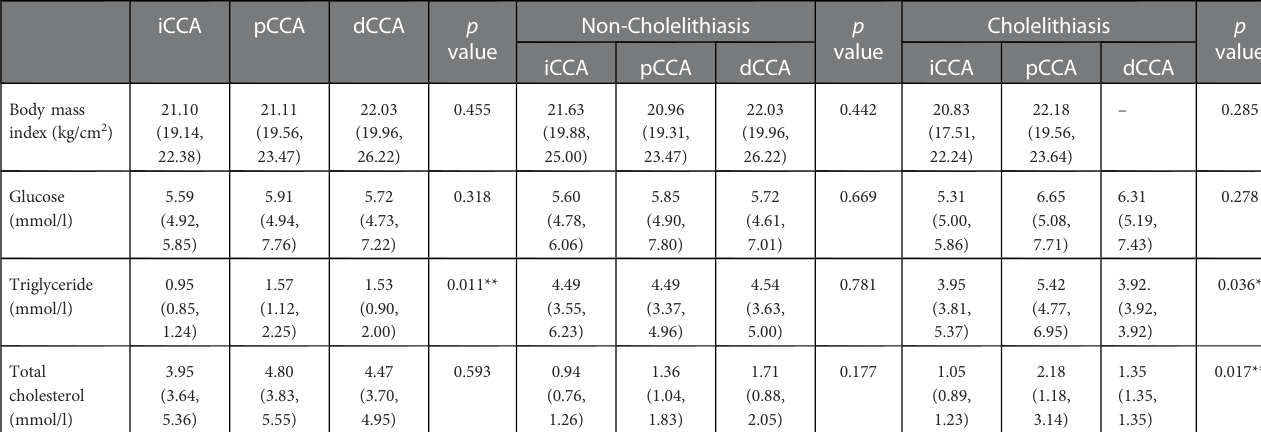
TABLE 2 BMI, glucose and lipid levels in CCA patients.